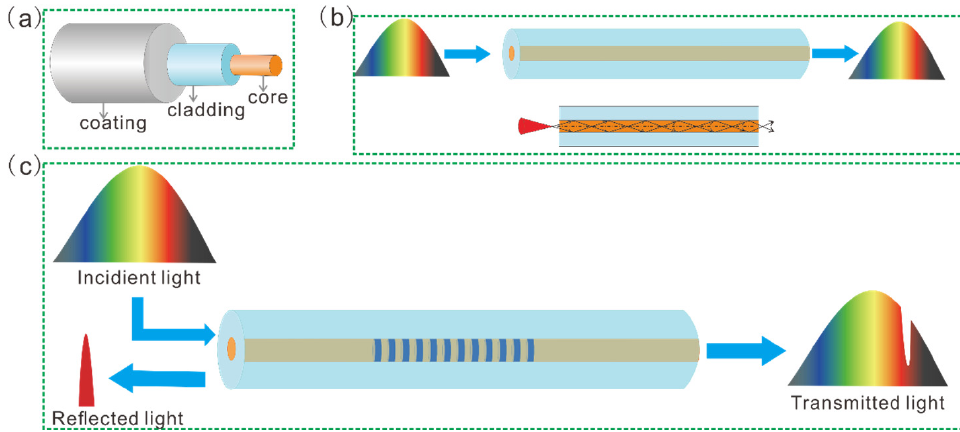
Figure 1. Working principle of the fiber Bragg grating (FBG). ( a ) optical fiber structure, ( b ) principle of total internal reflection, and ( c ) principle of FBG light Transmission.